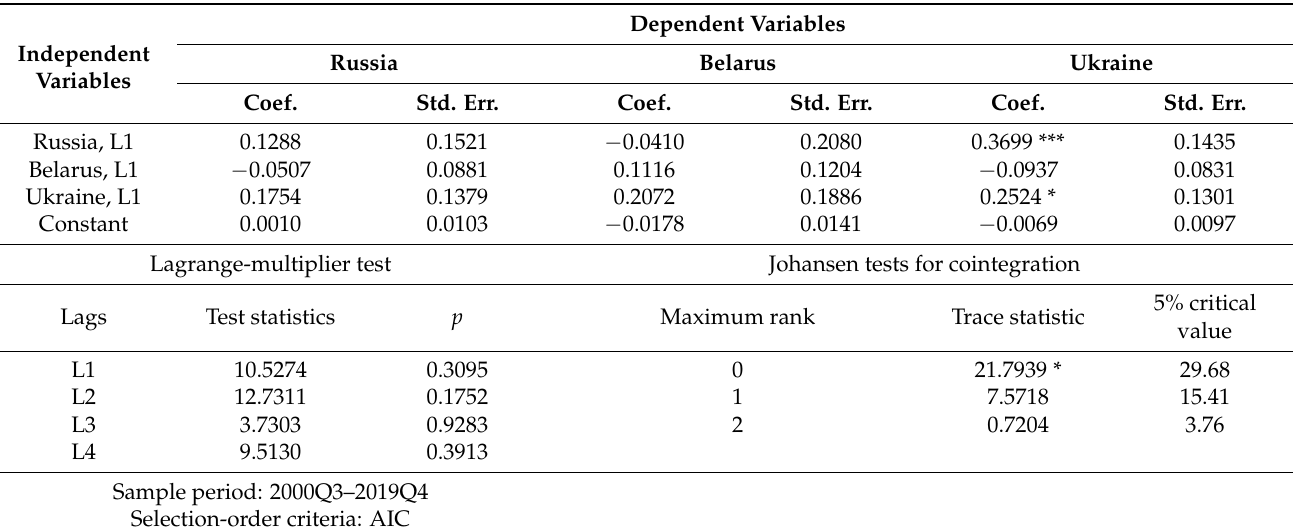
Table 9. VAR Model Estimation Results for Logarithmic Difference of GDP, Large Economies without Significant Fuel Resources.